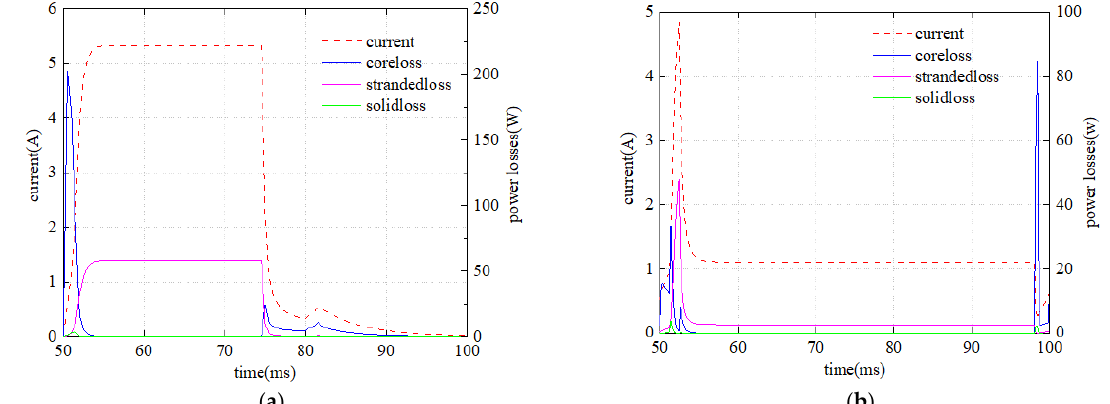
Figure 7. Power loss curve in the two driven strategies: ( a ) Power loss curve in single voltage strategies; ( b ) Power loss curve in PECA.